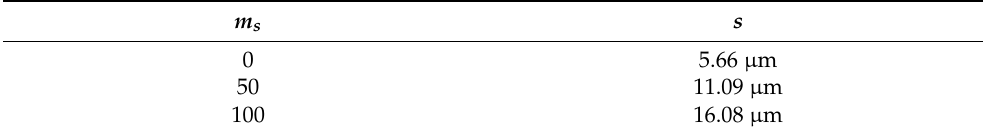
Table 2. Sliding distance of different inertial force coefficients.